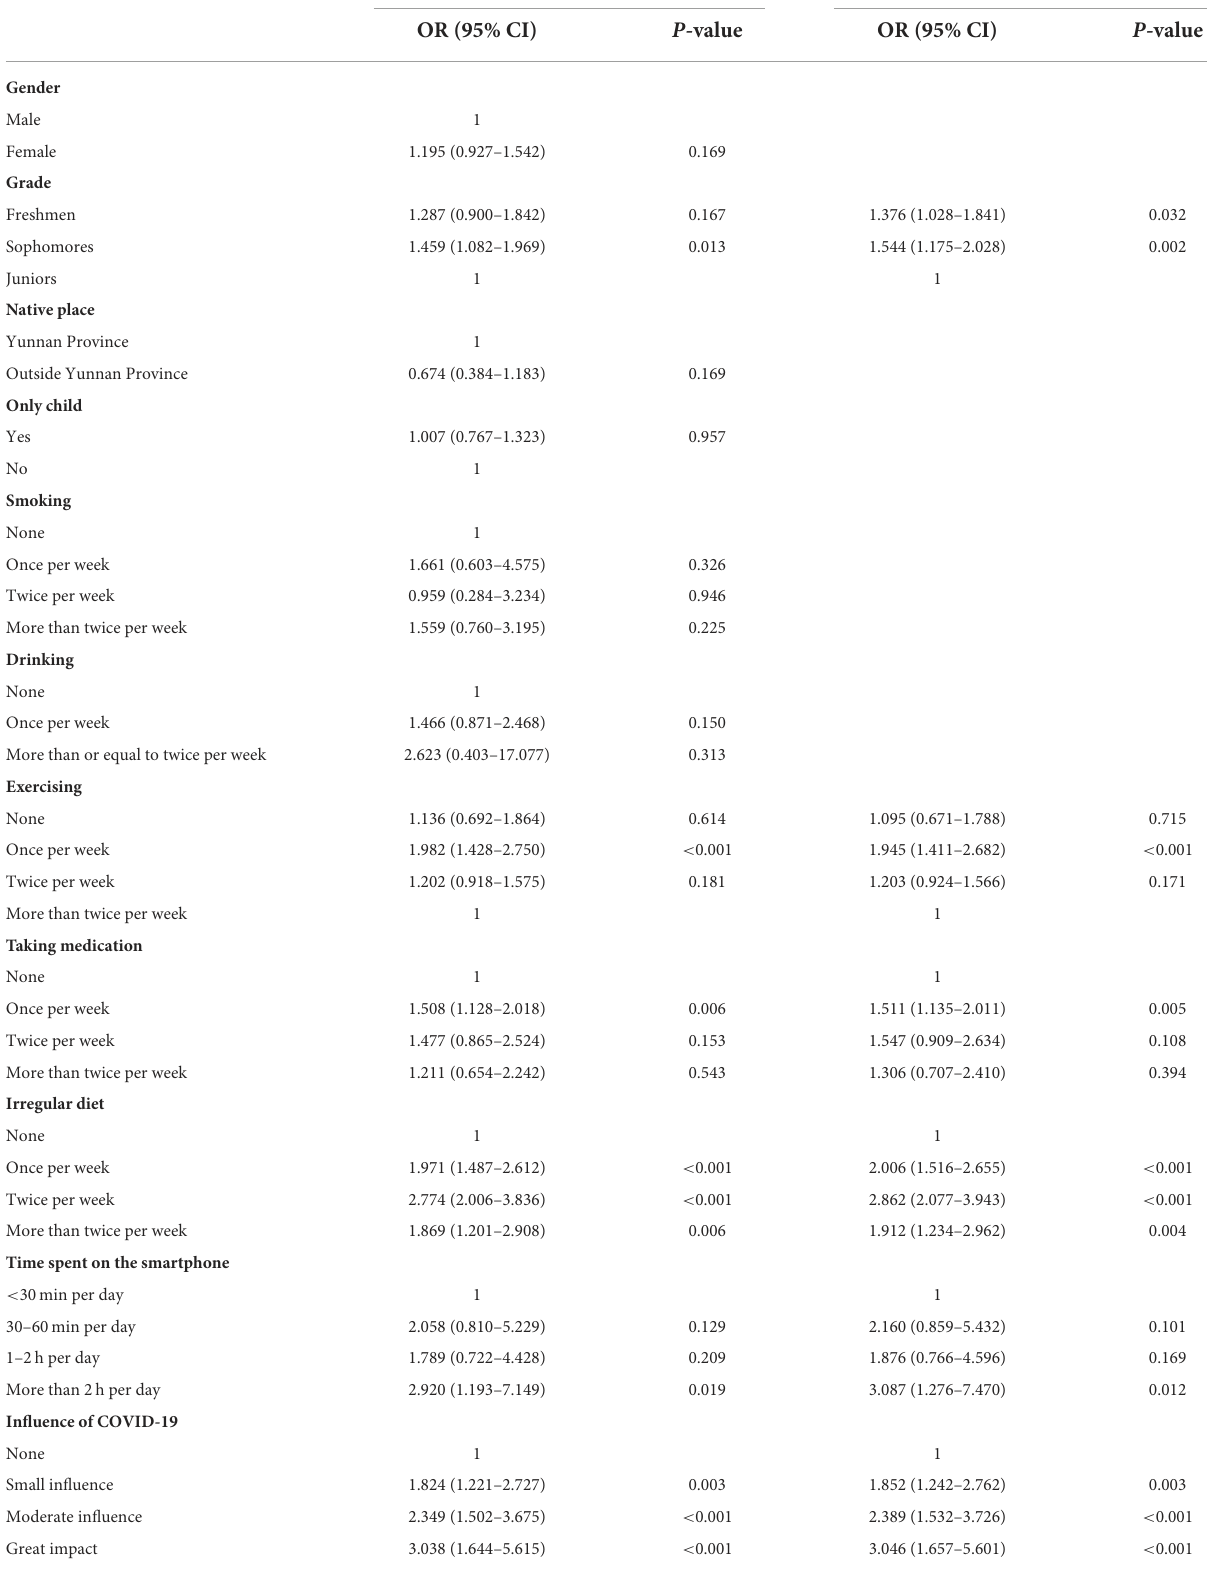
TABLE 3 Logistic regression analysis for risk factors of